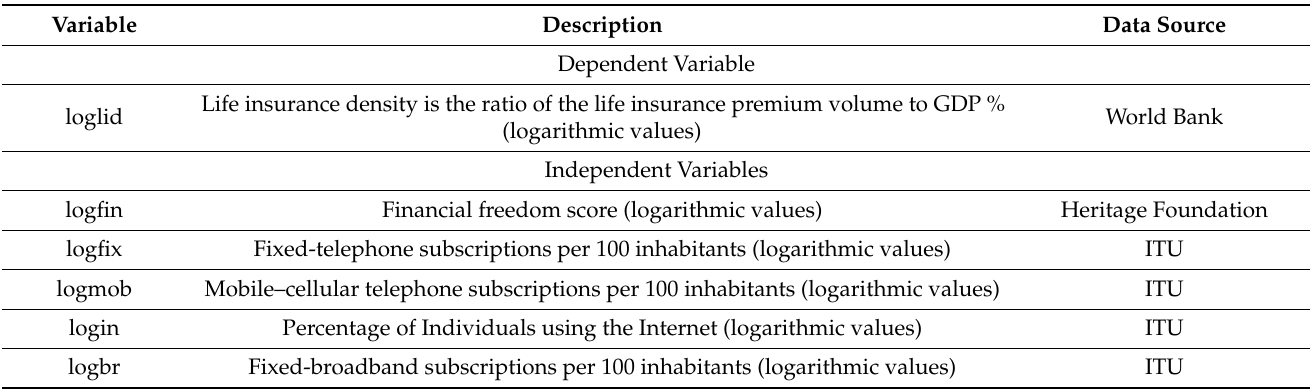
Table 2. Definition of variables and sources of data.